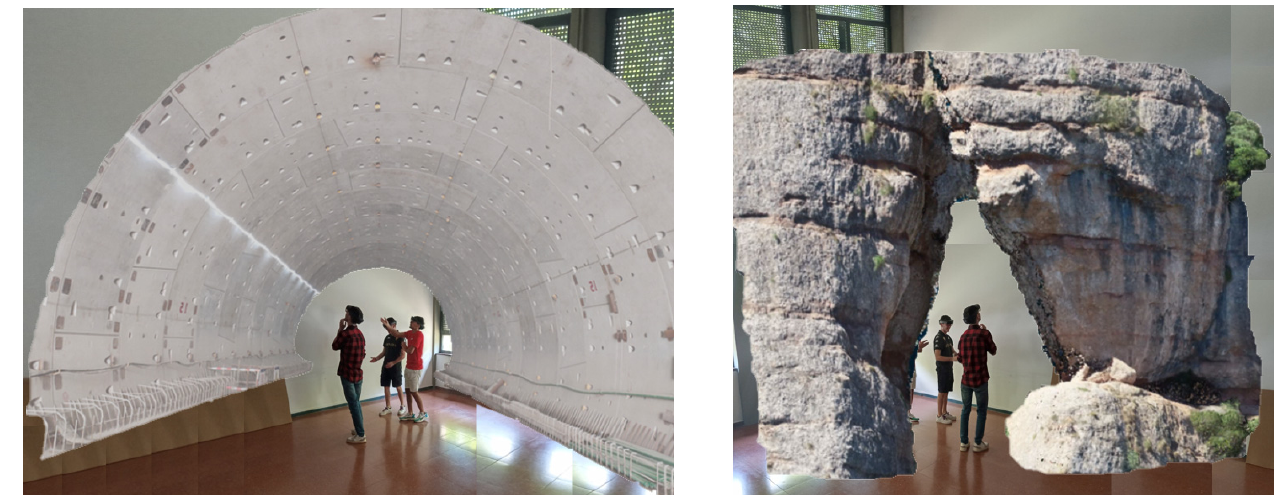
Figure 14. Examples of MR visualization when the model encloses the user: inside a tunnel section ( left ) and inside a cavern ( right ). The latter model corresponds to “La Foradada” site (Montserrat).